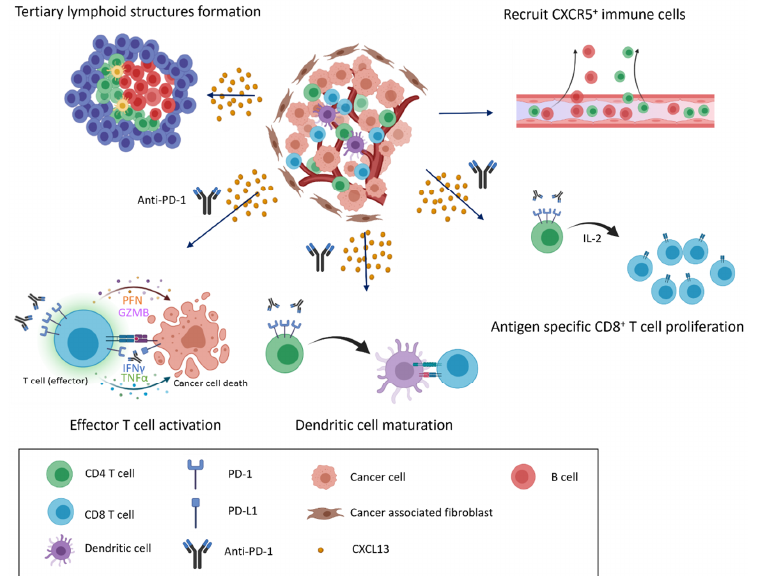
Figure 3. CXCL13/CXCR5 signaling and response to immune checkpoint blockade in the tumor microenvironment. CXCL13 secretion and enrichment in the tumor microenvironment alter the immune cell composition. CXCL13 recruits cells that express CXCR5 to infiltrate the cancer microenvironment, inducing the formation of tertiary lymphoid structures and the further infiltration of various immune cells ( top ). When anti-PD-1 antibodies are present, recruited immune cells actively attack cancer cells, and exhausted cells transition into effector cells, leading to the proliferation of CD8 + T cells and the maturation of dendritic cells in response to anti-PD-1 treatment ( bottom